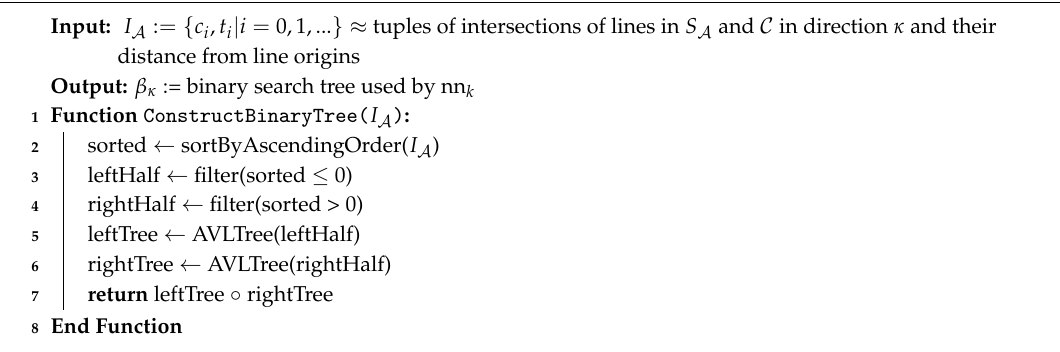
Algorithm A1 : Construction of binary search tree used in our